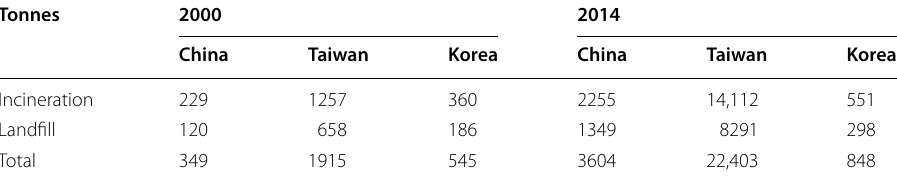
Table 6 Repercussion effects of visitor consumption on waste to be treated Tonnes